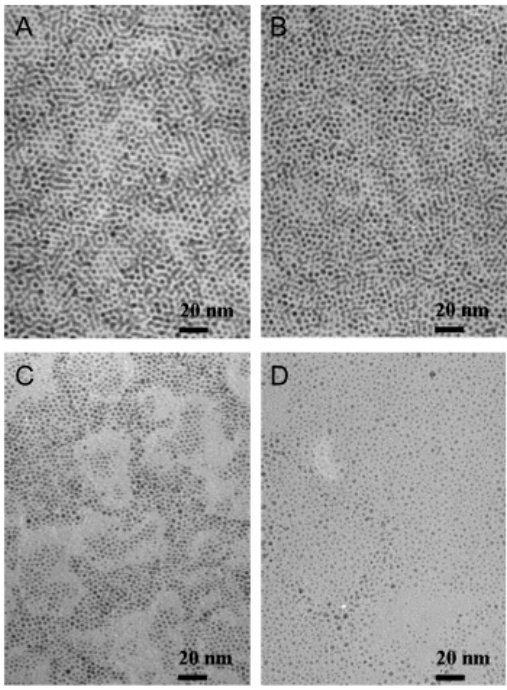
Figure 2. Transmission electron microscopy (TEM) micrographs of Gold NPs with various concentrations of polymer ligands. ( A ) 0.006mM ( B ) 0.03mM ( C ) 0.6mM and ( D ) 3.6mM